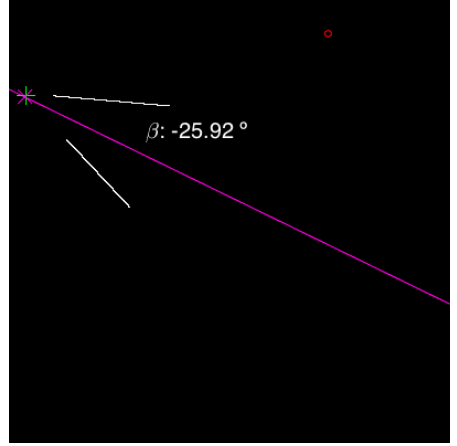
Figure 4. Segments (white) extracted from a rhombus and the obtained bisector (pink line), its orientation and the intersection point (pink cross) together with the theoretical intersection (green cross) and rotation centre (red circle).